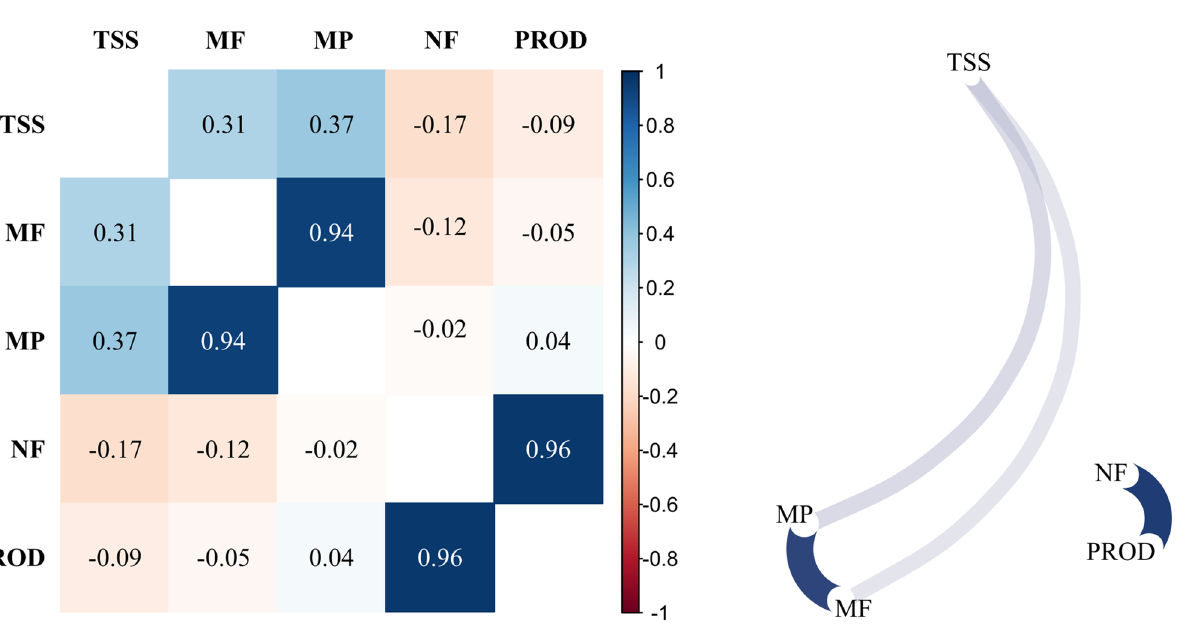
Table 3. Predict accuracy and standard deviation of heritability for soluble solids content (TSS), fruit mass (FM), pulp mass (PM), number of fruits per plant (NF) and production per plant (PROD) observed in guava ( Psidium guajava ), estimated using a model with SSR markers and Bayesian ridge regression—BRR.